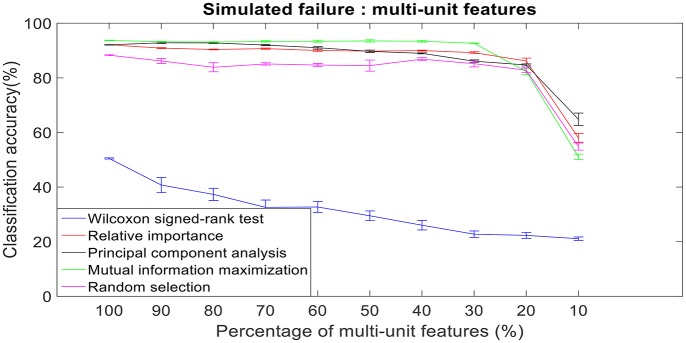
Robustness to simulated failure of multi-unit features. The plot above shows the cross-validated classification accuracy at various failure levels. Error bars indicate standard error of the cross validation folds.